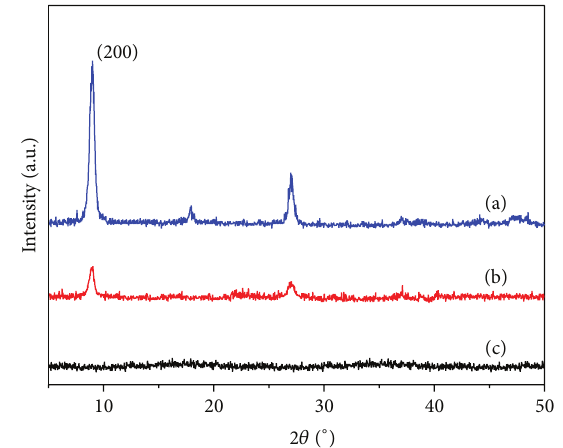
Figure 3: X-ray diffraction patterns of (a) VMT powder, (b) the composite electrolyte membrane with 6 wt% VMT, (c) the composite electrolyte membrane with 0 wt%